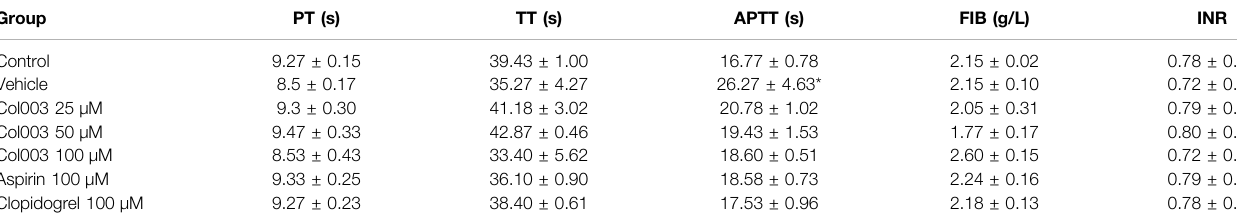
TABLE 1 | Effect of Col003, aspirin, and clopidogrel on plasma coagulation parameters in vivo (mean ± SD, n (cid:1) 3 – 4). Group PT (s) TT (s) APTT (s) FIB (g/L) INR